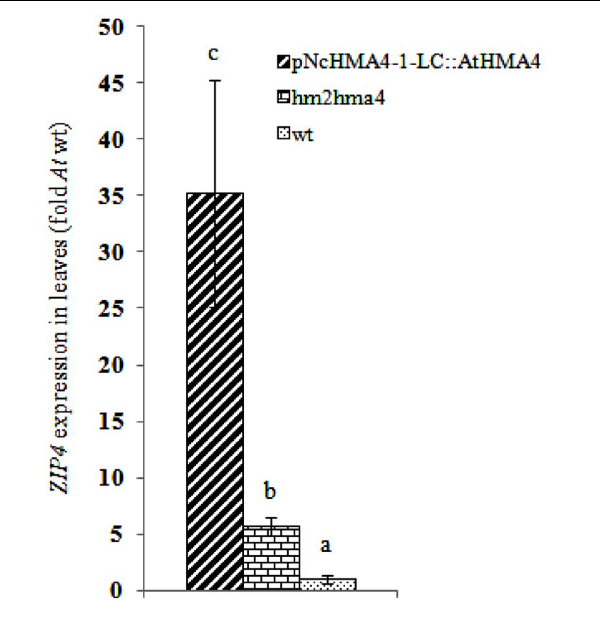
FIGURE 9 |Average ZIP4 expression in leaves in transgenic lines expressing AtHMA4 under the pNcHMA4-1-LC , the hma2hma4 double mutant, and wild-type (fold expression relative to Arabidopsis wt) . Significant differences ( P < 0.05) between means are indicated by different superscripted letters.